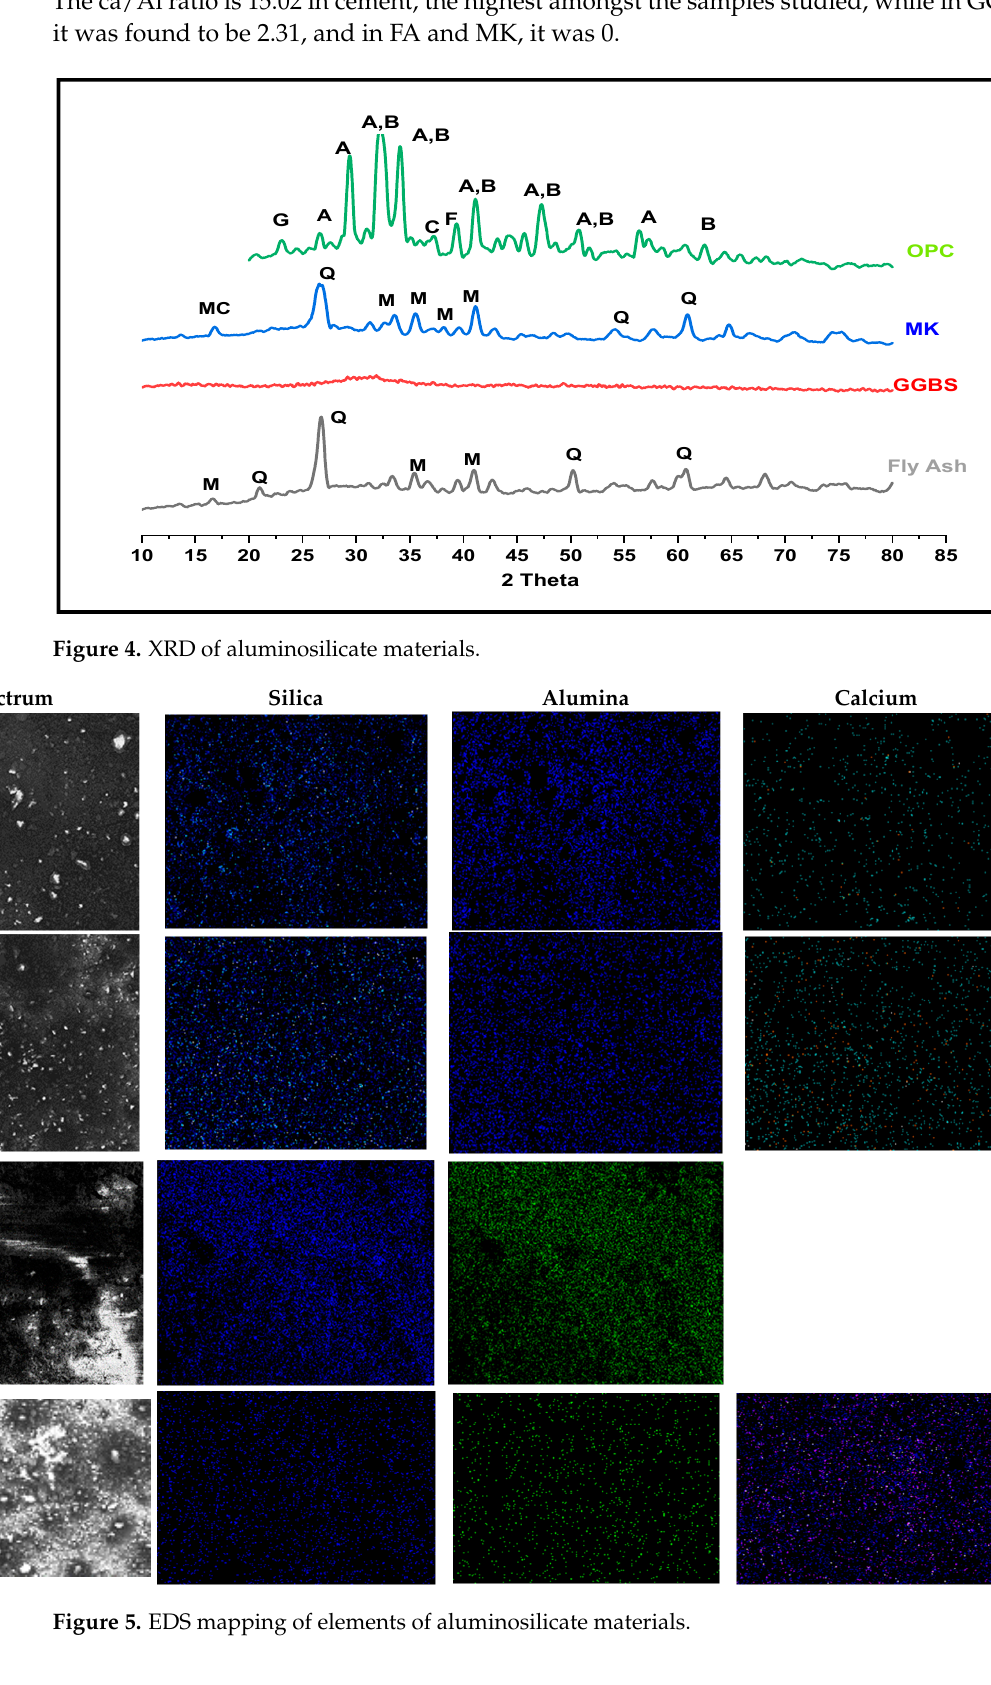
Figure 3. FE-SEM images of aluminosilicate materials.